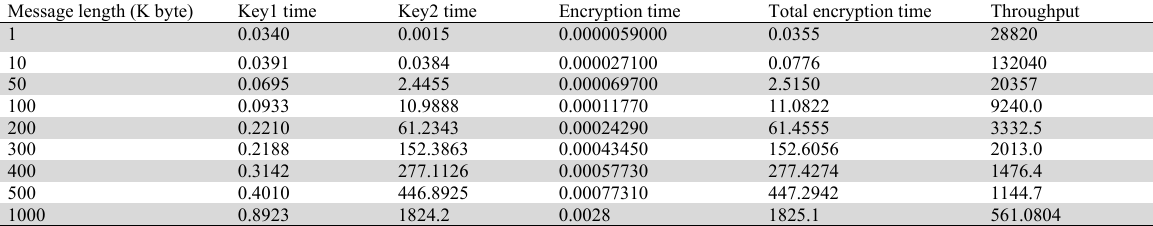
Long messages encryption times (image_key H3) Message length (K